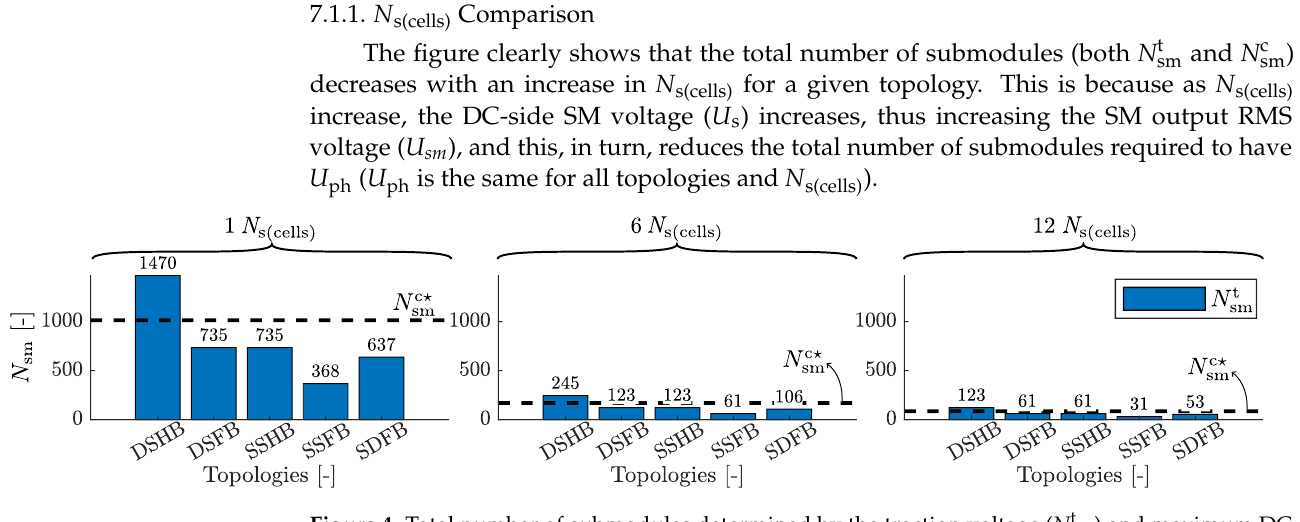
Figure 4. Total number of submodules determined by the traction voltage ( N t sm ) and maximum DC charger voltage ( N c (cid:63) sm ) for all topologies with 1, 6, and 12 N s(cells)